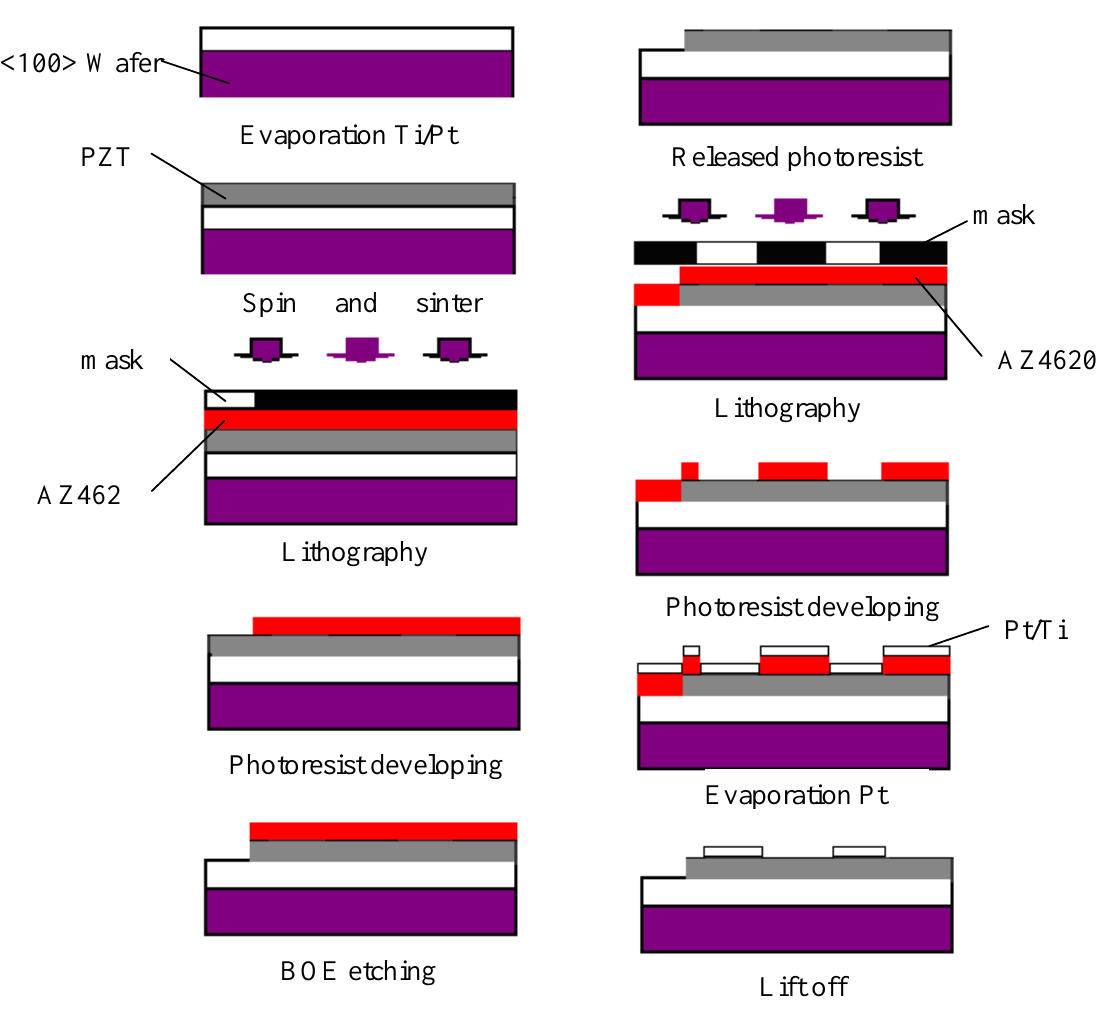
Figure 1. Preparation of